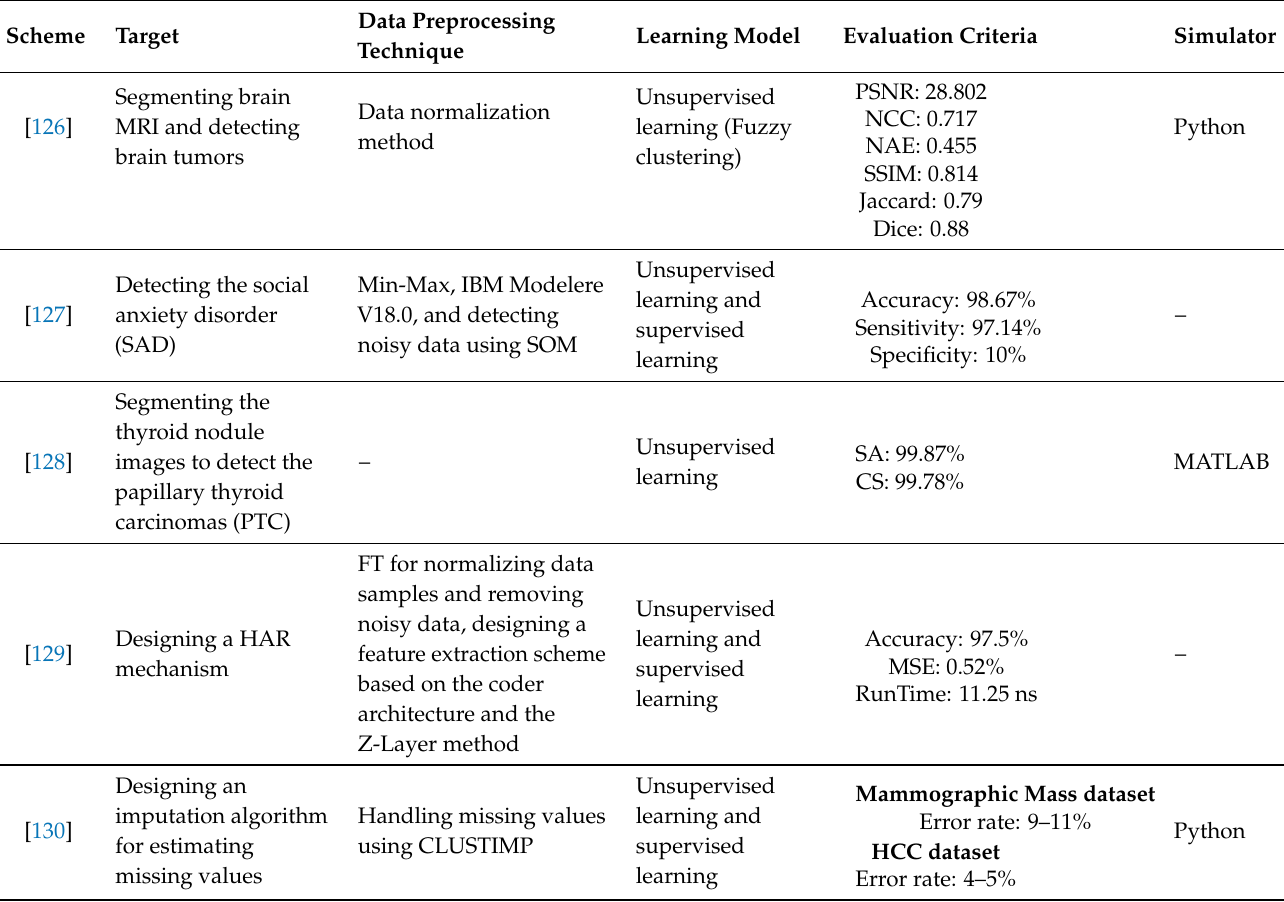
Table 14. The most important characteristics of unsupervised learning-based models.